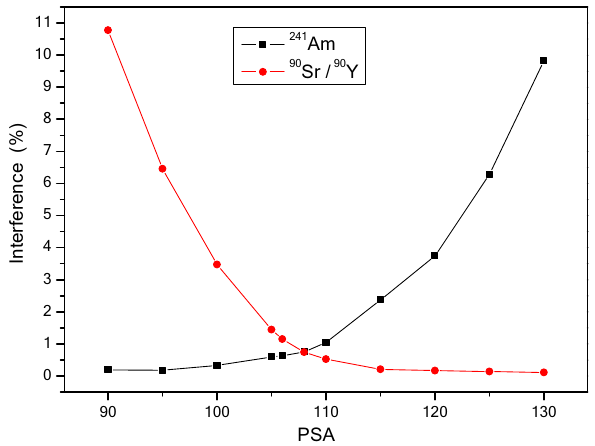
Figure 1. Calibration curves of alpha and beta interferences under different PSA settings.